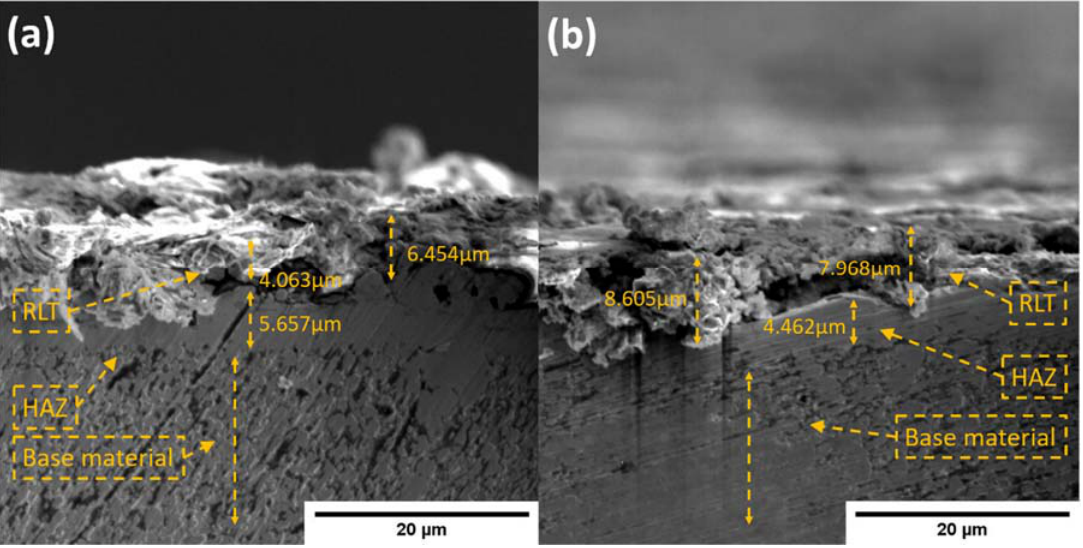
Figure 7. Recast layer thickness of machined surface at 5000 × magnification with Si powder concentration ( a ) 5 g/L ( b ) 10 g/L.